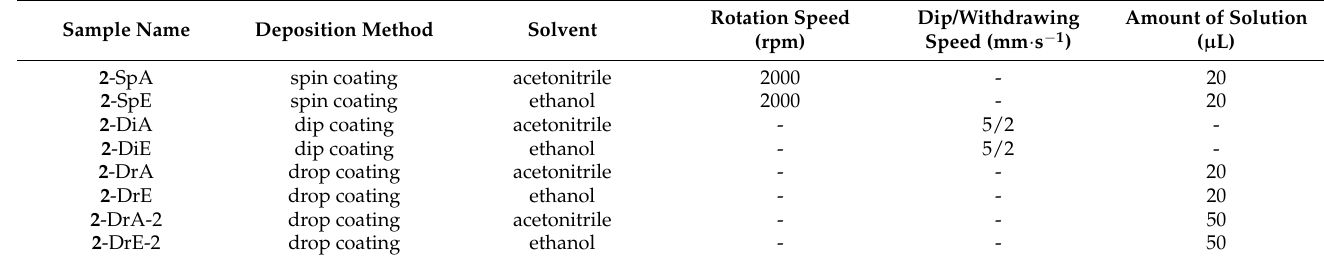
Table 1. Deposition parameters for the samples discussed in this